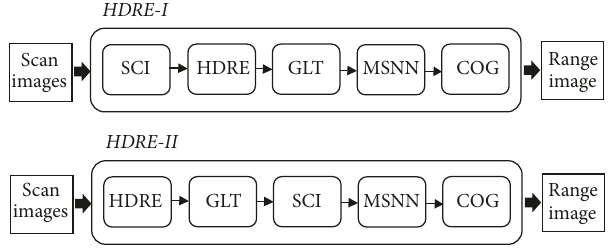
Figure 19: Data flow graph for Experiment